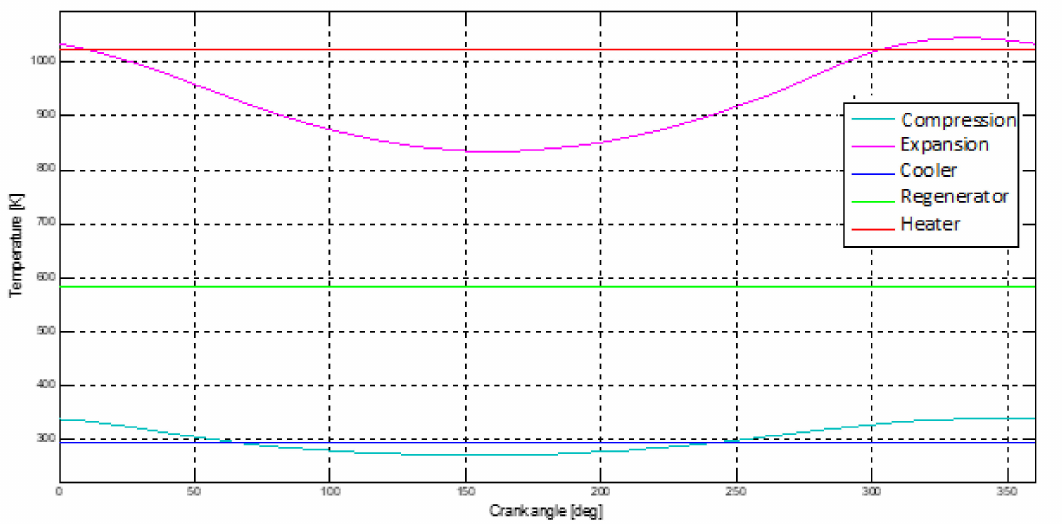
Figure 12. Temperature distribution of the adiabatic model.